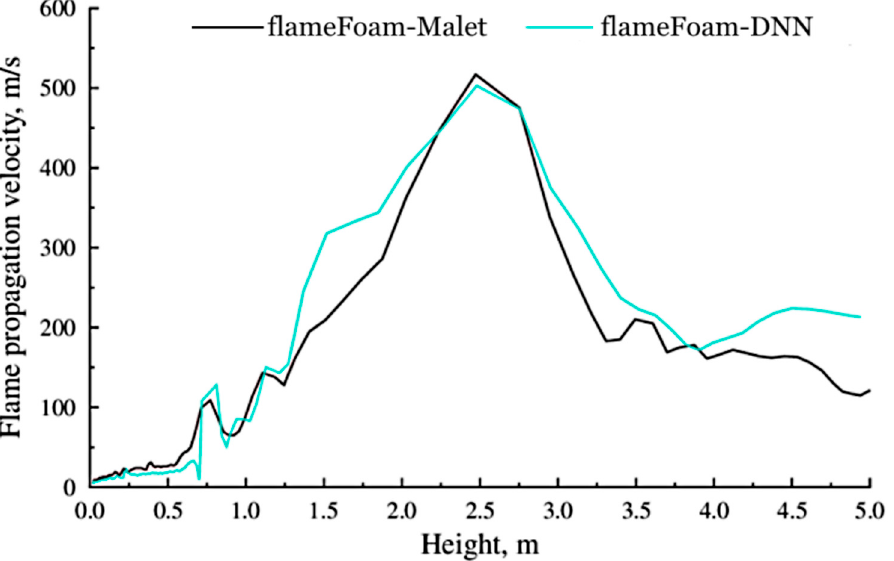
Figure 8. Vertical flame propagation velocity profiles in ENACCEF2 facility.